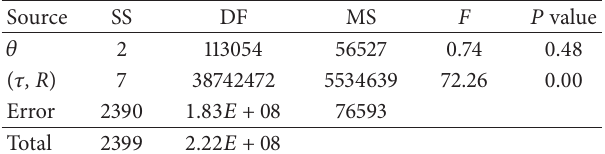
Table 4: ANOVA table for the number of nodes with 𝑛 = 12 and 𝑃 = 0.5